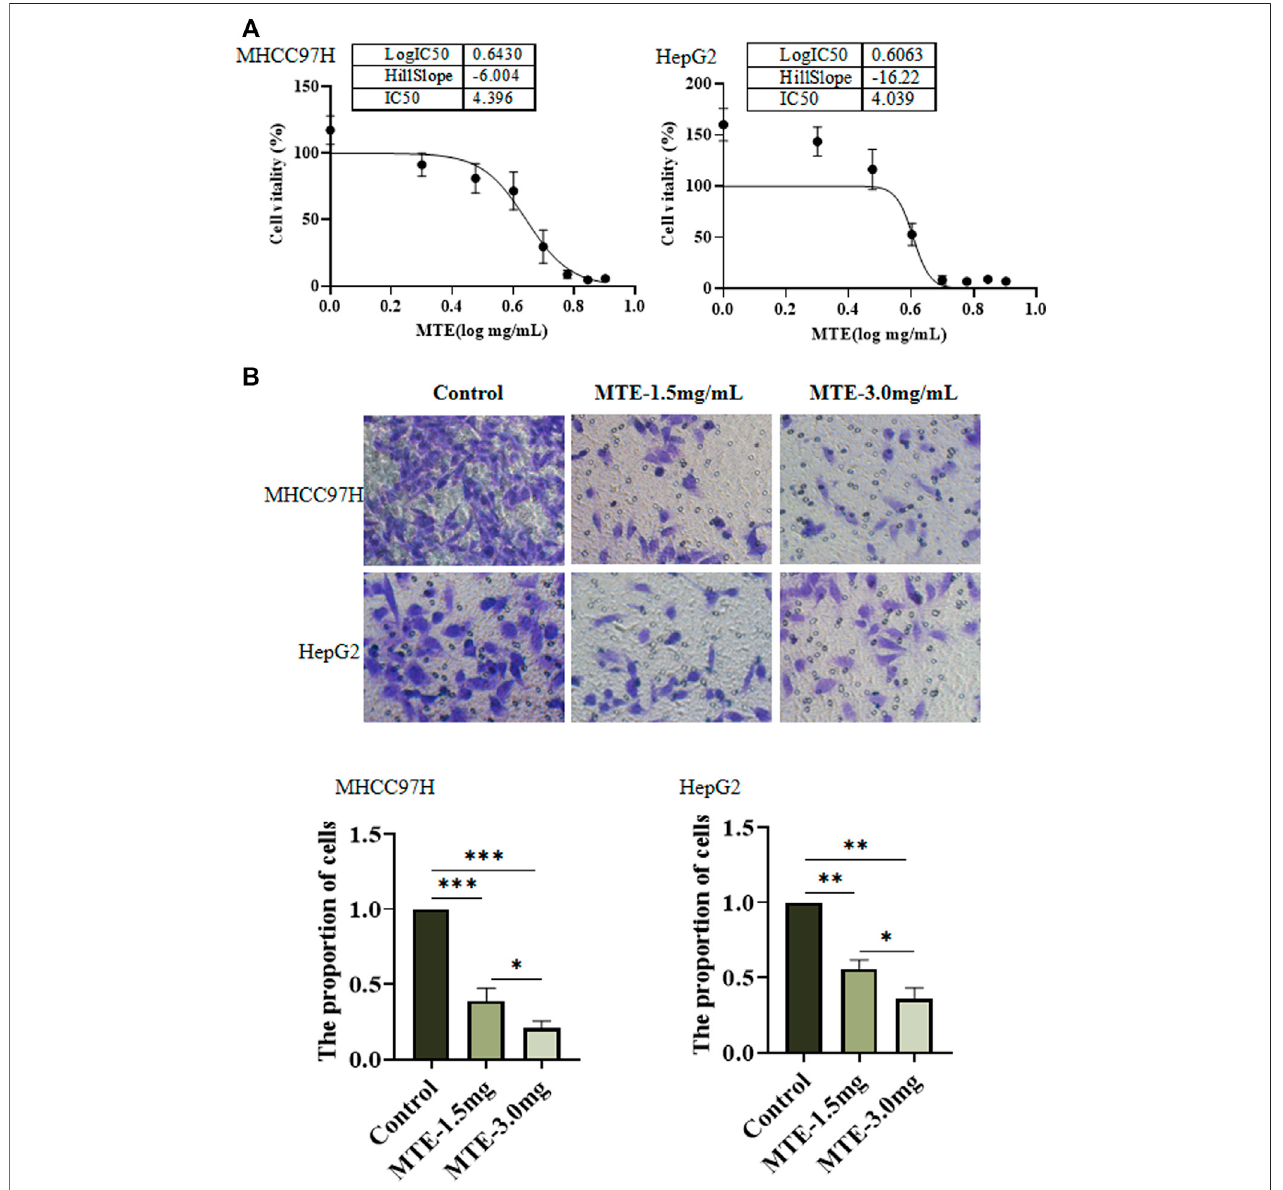
FIGURE 1 | MTE inhibited the viability and migration of HCC cells in vitro . (A) MHCC97H and HepG2 cells were seeded in 96-well plates and exposed to MTE at differentconcentrations (0, 1,2, 3, 4,5, 6,7, and 8 mg/ml)for 24 h toassess cell viabilityby CCK-8 assay. (B) MigrationpotentialofMHCC97H and HepG2cells with or without MTE treatment was measured by transwell assay. ** p < 0.01; NS, not signi fi cant.